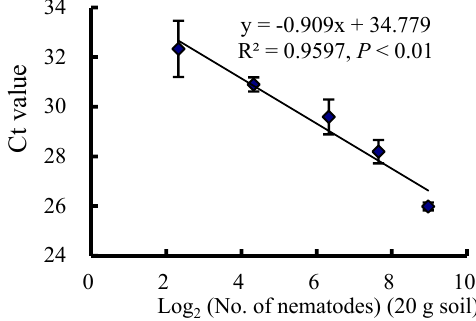
Figure 3. Relationship between the number of Meloidogyne incognita eggs inoculated into 20 g soil and Ct values. Values are mean ± SD ( n = 3).